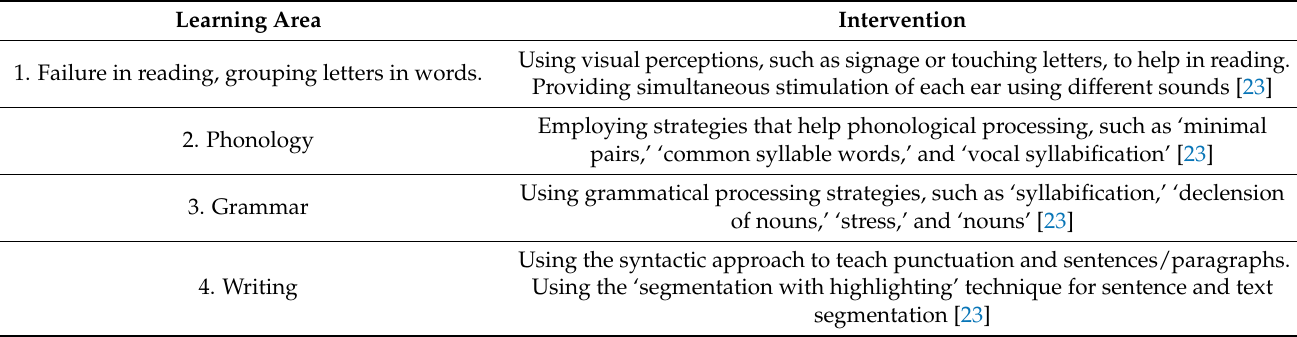
Table 2. Individualised educational practices in schools for children with